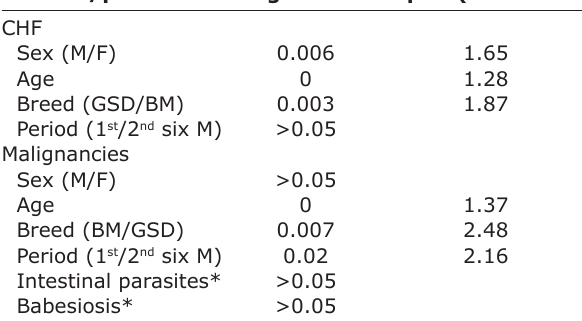
Table-3: Significant associations between the most prevalent diagnoses and the dogs’ characteristics and their odds